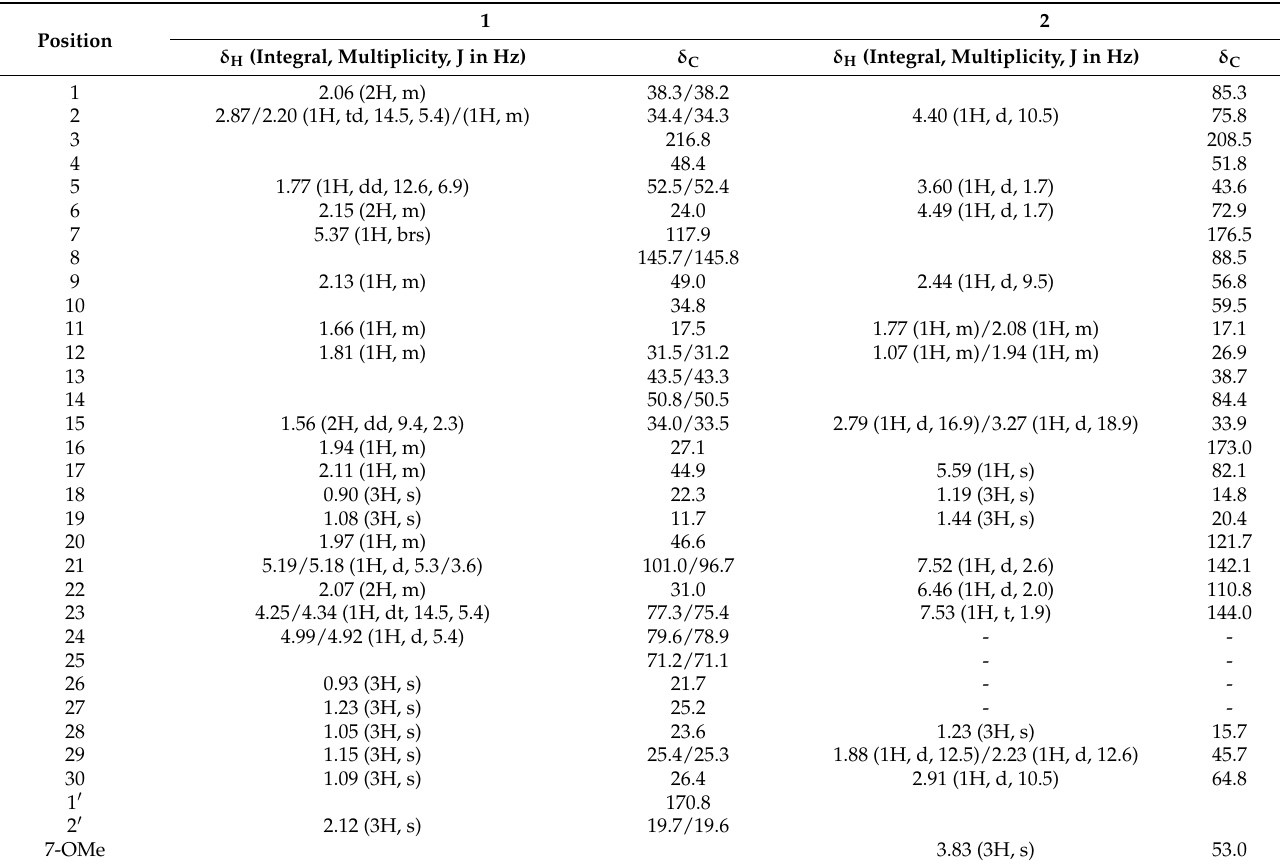
Table 1. 1 H and 13 C NMR data of compounds 1 and 2 (CD 3 OD, 500, and 125 MHz, respectively). 1 Position